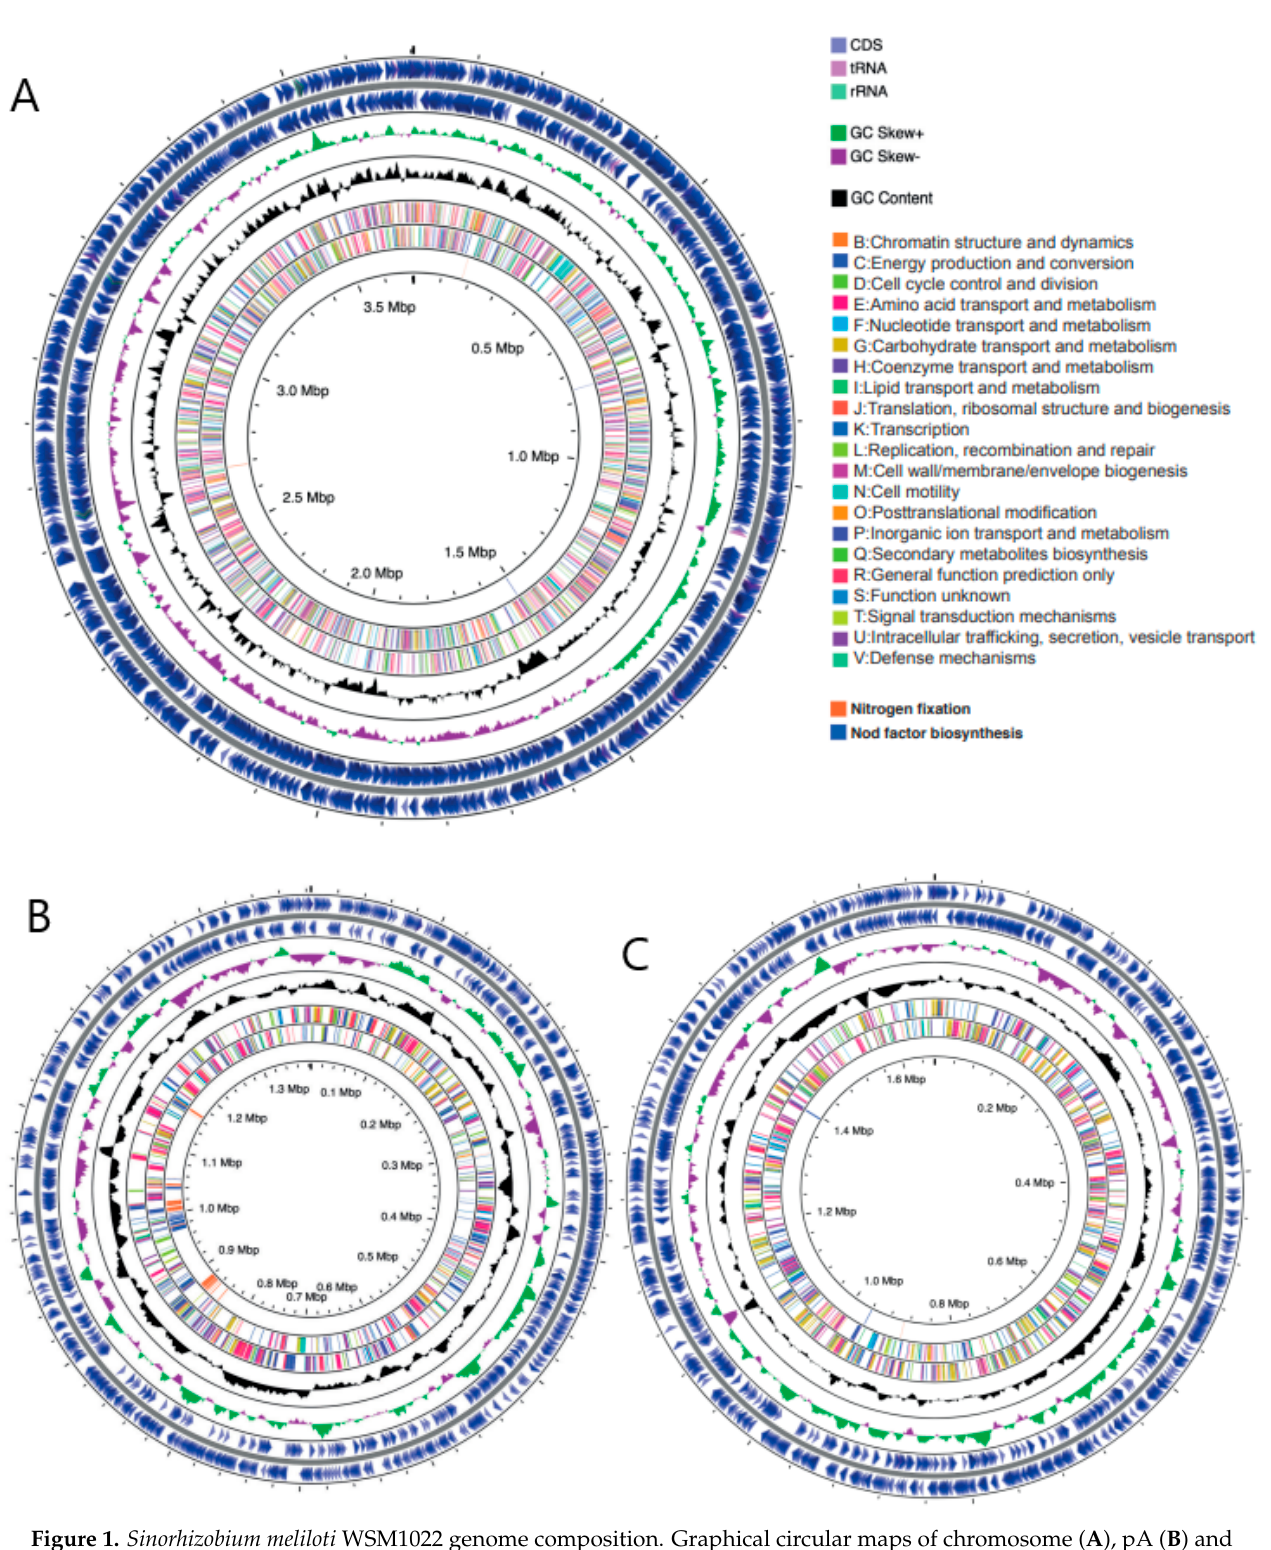
Figure 1. Sinorhizobium meliloti WSM1022 genome composition. Graphical circular maps of chromosome ( A ), pA ( B ) and pB ( C ), generated using CGView. From outside to centre, rings show CDS (lilac), tRNA (pink) and rRNA (sage green) on the forward and reverse strand; positive and negative GC skew (green and purple, respectively); GC content (black); COG category (colours in key) on forward and reverse strands; Nitrogen fixation genes (orange) and Nod factor biosynthesis genes; (blue); genome position in Mbp.